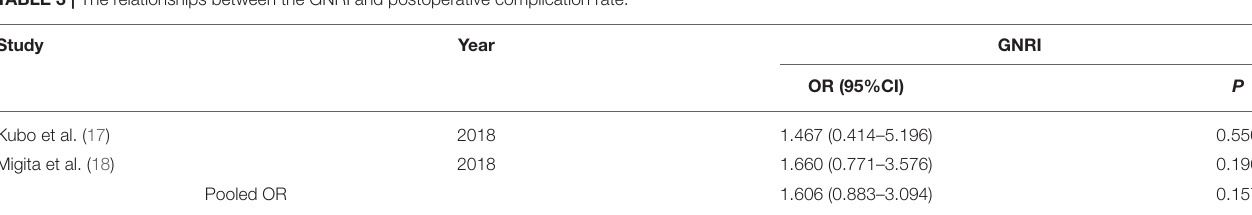
TABLE 3 | The relationships between the GNRI and postoperative complication